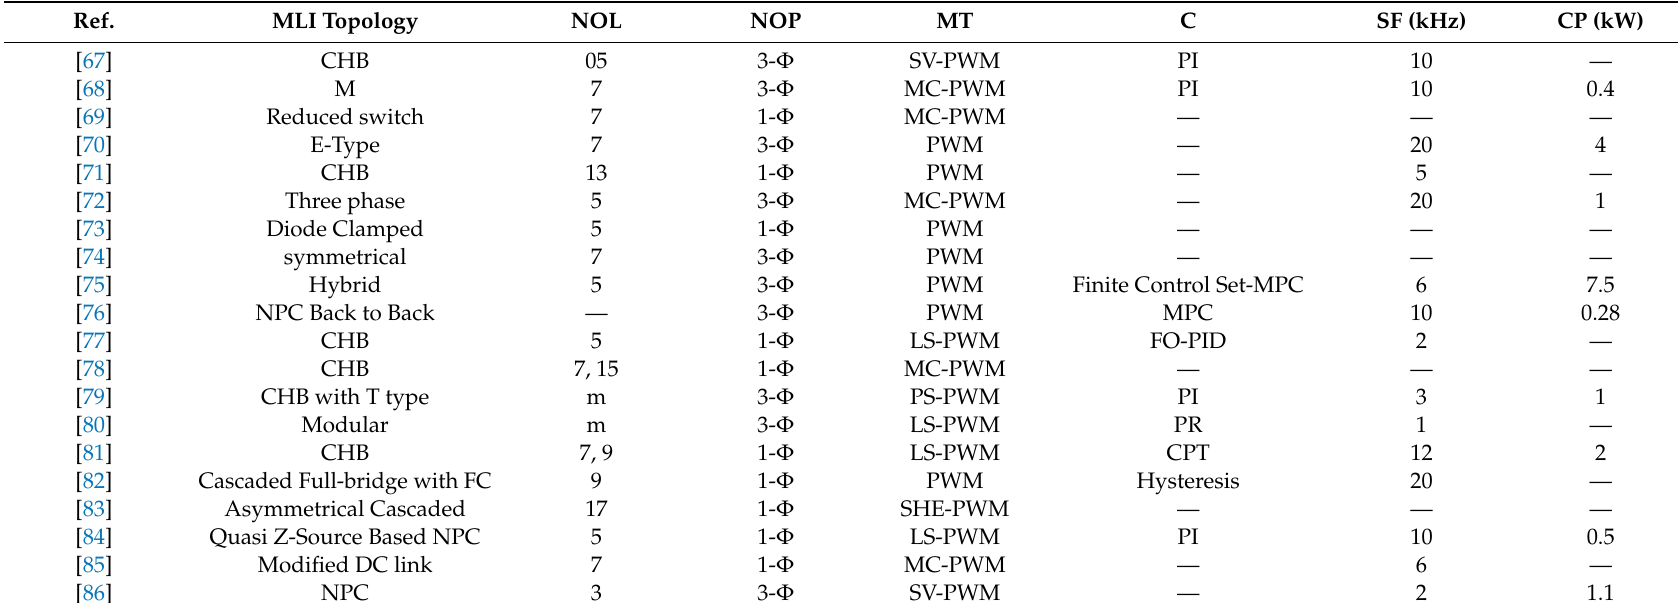
Table 4. Analysis of di ff erent grid-connected multilevel